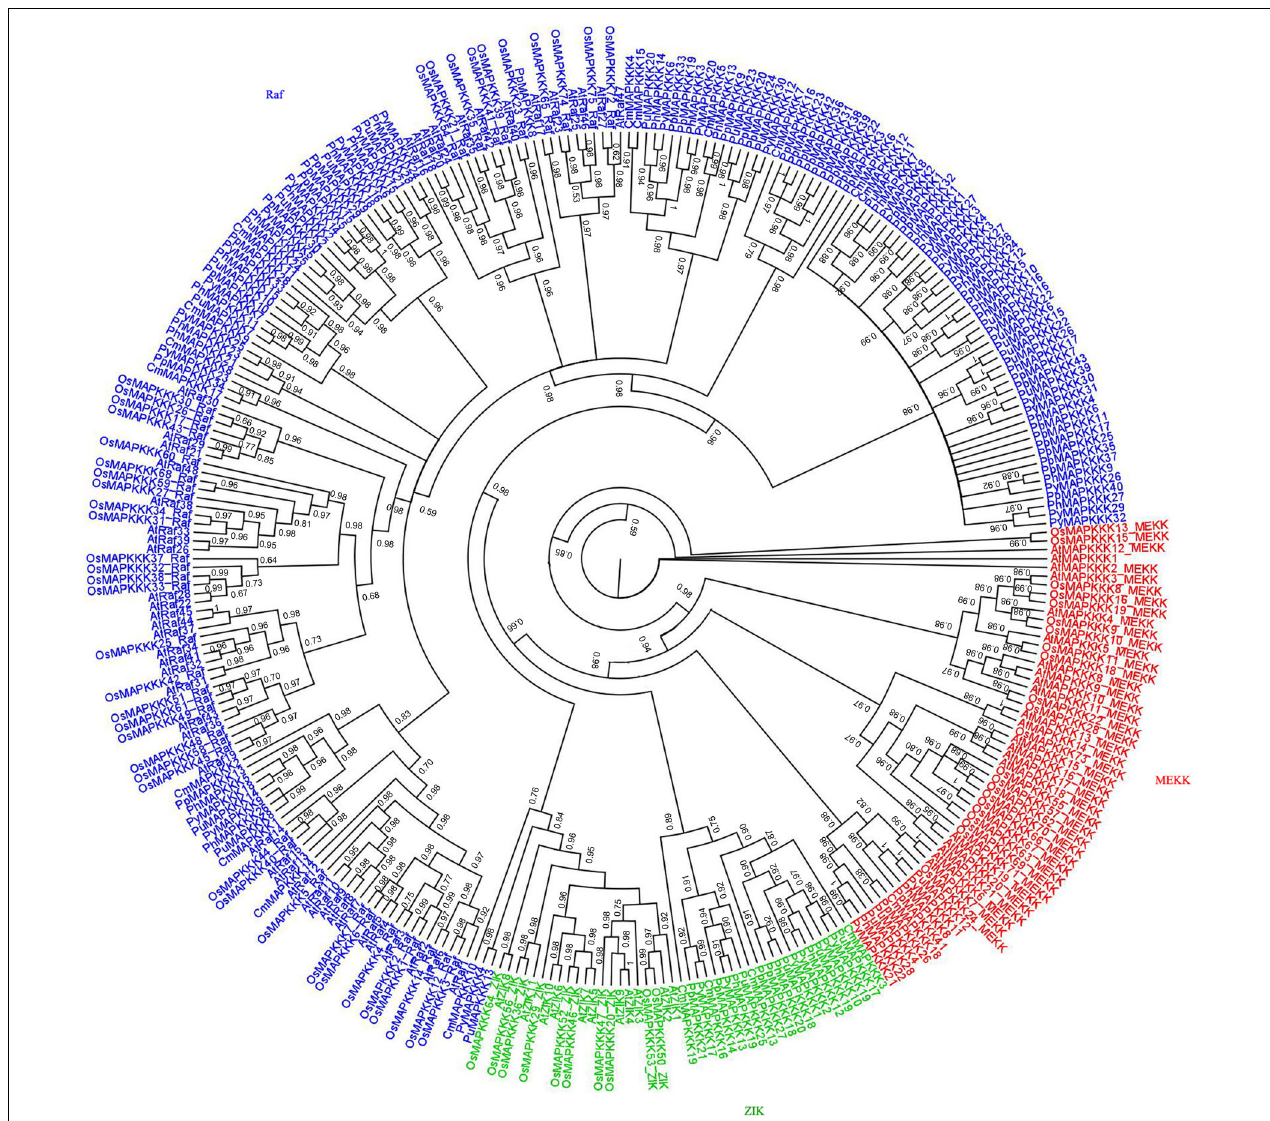
FIGURE 4 | Phylogenetic tree of MAPKKKs from five red algae, rice, and Arabidopsis . Phylogenetic tree was created using bayes_3.2.5, using protein kinase domain of 307 MAPKKK proteins, using protein kinase domains of 152 red algae, 75 rice and 80 Arabidopsis MAPKKK proteins. Red labeled MEKK subfamily, green labeled ZIK subfamily, blue labeled Raf